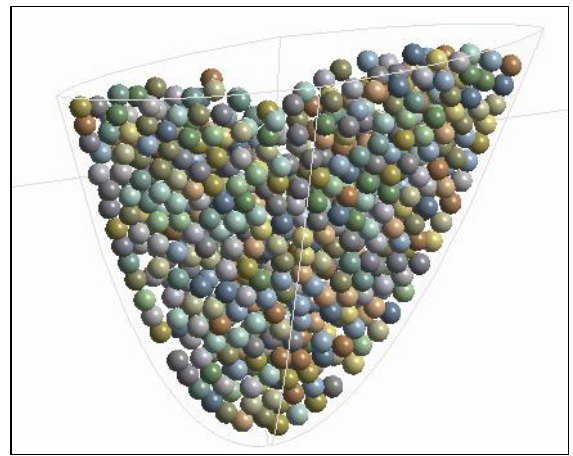
Figure 8. Fracture filled by proppant.